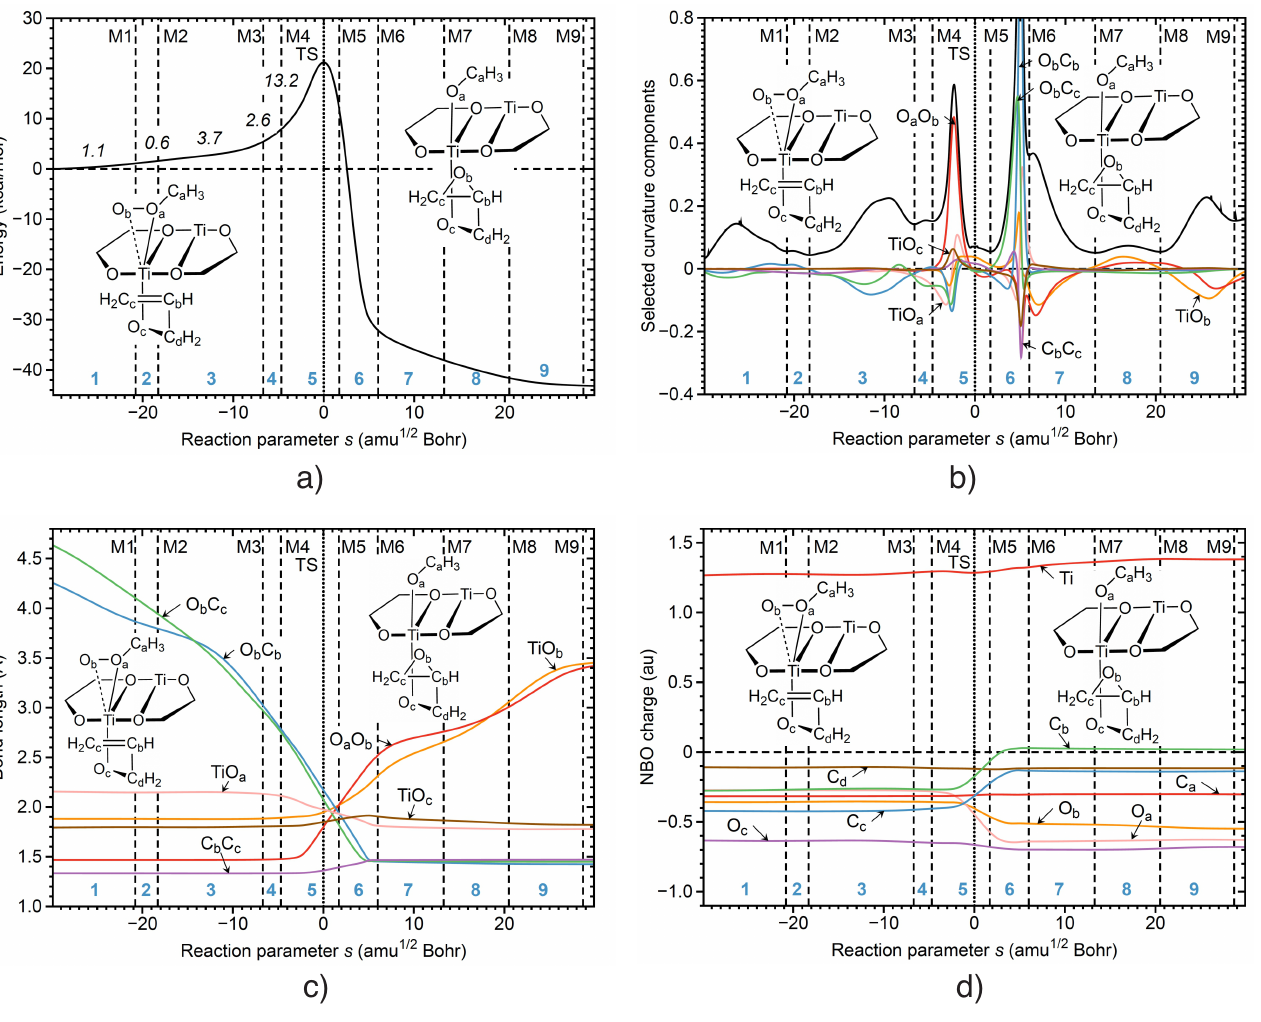
Figure 4. Properties of reaction R1 along the reaction path. ( a ) The energy profile, where the energy contributions of each reaction phase to the activation energy are indicated by italic numbers. ( b ) Decomposition of the reaction curvature into selected geometry components. ( c ) The change of the selected bond lengths. ( d ) The change of the selected NBO atomic charges. The curvature minima are shown as broken vertical lines and are labeled as M1, M2 and so on. The position of TS is indicated as a dotted line. The reaction phases are indicated by blue numbers. B3LYP/6-31G(d,p)/SDD(Ti) level of